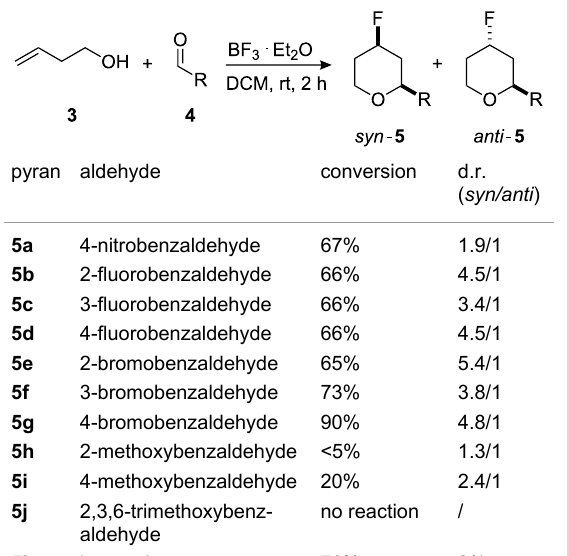
Table 1: Prins fluorination reaction of homoallylic alcohol ( 3 ) with various aldehydes 4 giving substituted fluoropyrans 5 . Reaction condi- tions: BF 3 ·OEt 2 (1 equiv), but-3-en-1-ol (1 equiv), aldehyde (1 equiv), DCM, rt, 2 h.